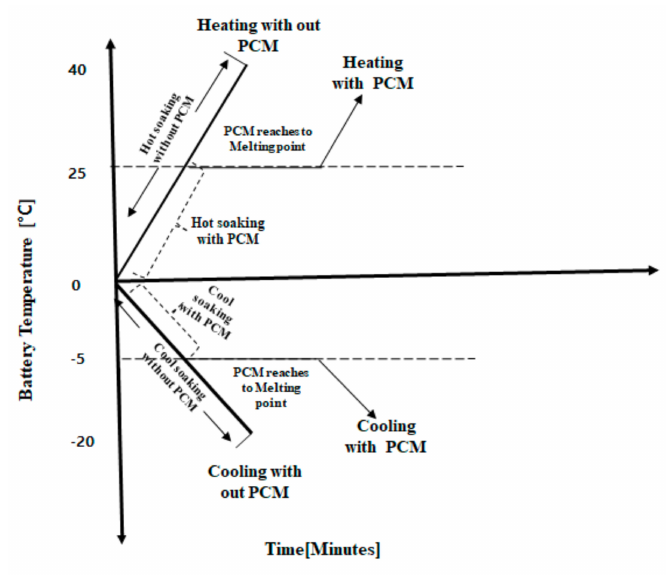
Figure 4. Principle of PCM during hot and cool soaking.